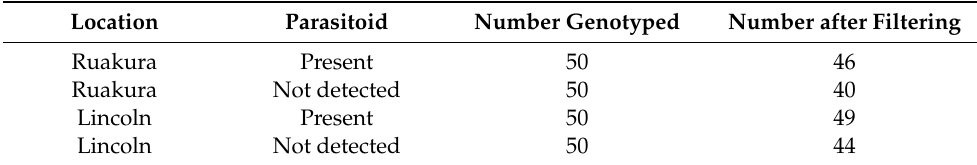
Table 3. Number of parasitised and unparasitised weevils from Ruakura and Lincoln. Location Parasitoid Number Genotyped Number after Filtering Ruakura